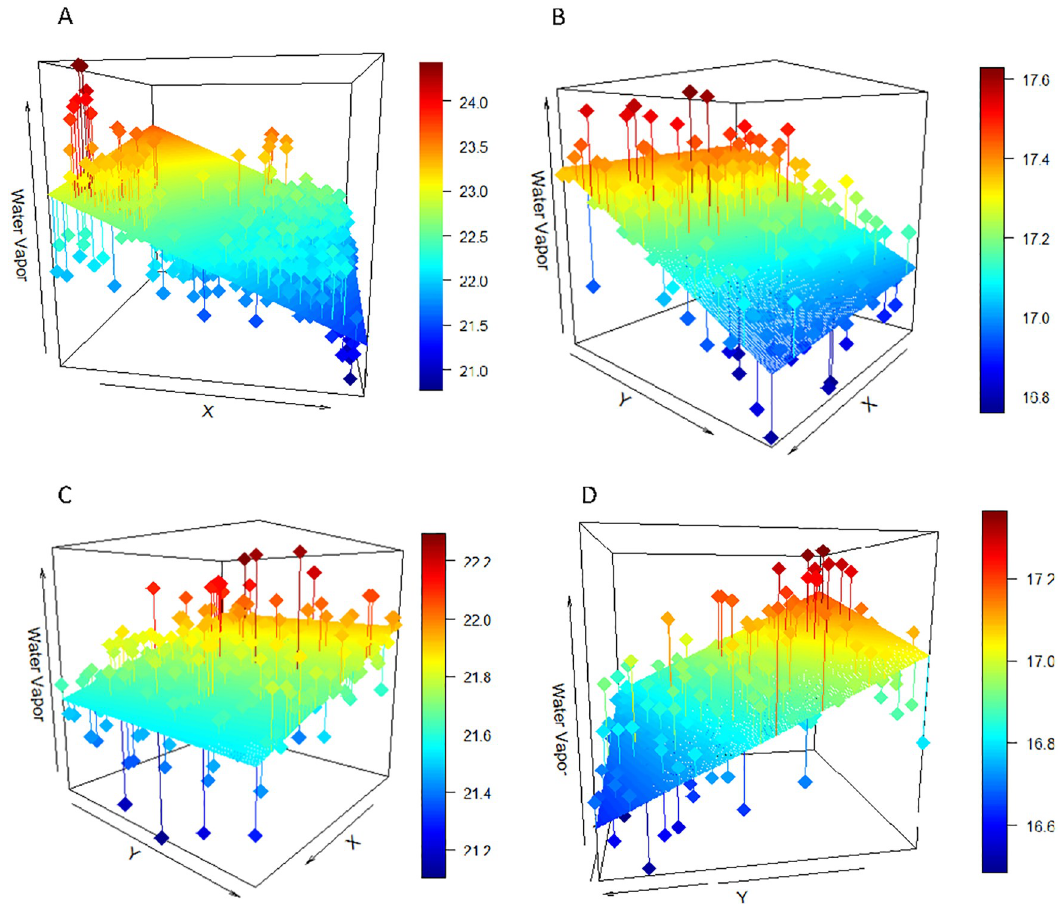
Fig 9. Linear surface trends for four fields. A: Corn field from 2013 (slope: 2.45, r 2 : 0.54, directional difference: 20˚), B: Pistachio field from 2013 (slope: 0.55, r 2 : 0.34, directional difference: 7.7C: Peach field from 2015 (slope: 1.18, r 2 : 0.55, directional difference: 7.0˚), D: Mandarin field from 2015 (slope: 1.40, r 2 : 0.59, directional difference: